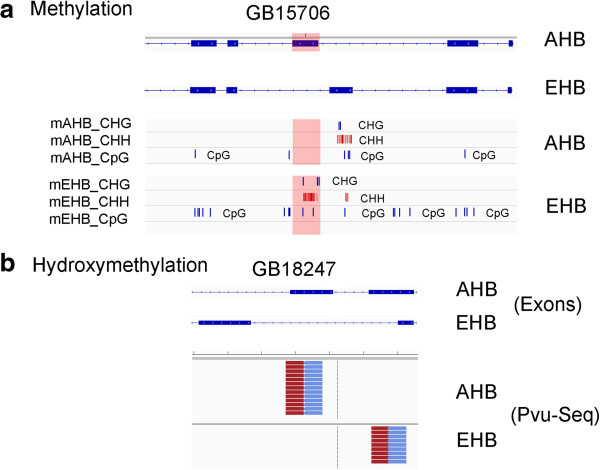
Non-CG cytosine modifications might affect alternative mRNA splicing. a, top blue lines indicated alternatively spliced exons in AHB and EHB. Underneath the exon sequences are the BS-Seq results showing the locations of CpG, CHG, and CHH mC sites. Note that mC in an exon correlates with the skipping of the exon by alternative splicing. For example, the gene GB15706, which encodes a homolog to Chromatin assembly factor 1 subunit A (CAF1A), has heavy CpG, CHH, and CHG methylation in a downstream exon that is skipped in AHB and present in EHB. Conversely, this gene has heavy cytosine methylation in the upstream exon in EHB that is skipped in EHB but present in AHB. Details of the RNA-seq analyses is in Additional file
1: Figure S7. b, Top blue lines indicated alternatively spliced exons in AHB and EHB, The red-and-blue stacked lines underneath the exons show Pvu-Seq analyses of AHB and EHB heads. Note that hmC also correlates with alternative mRNA splicing, but in manners that differ from mC (see text). Details of the RNA-seq analyses are given in Additional file
1: Figure S7.